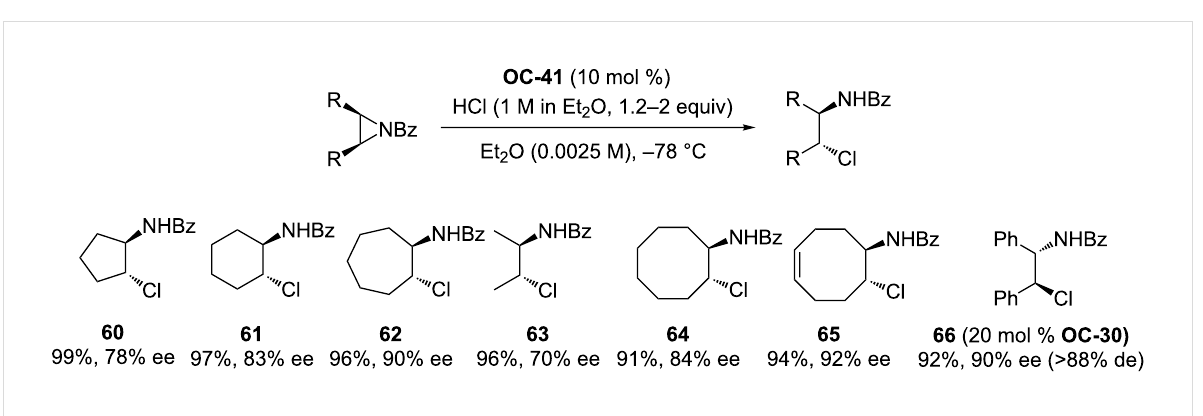
Scheme 8: Desymmetrization of meso -aziridines with OC-41 .